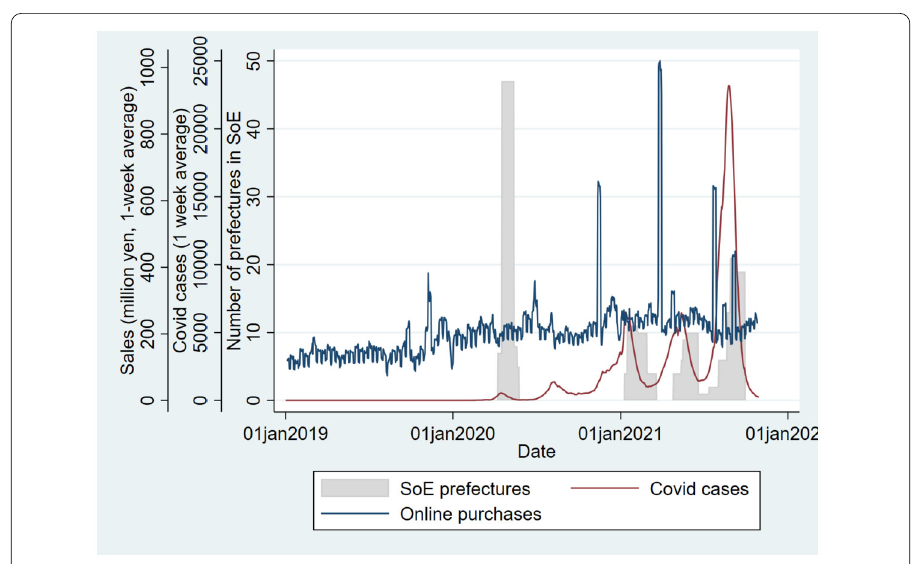
Figure 2 Changes in COVID-19 Cases and Online Purchases and Buyers over Time from January 1, 2019, to October 30, 2021. This figure shows the total number of daily positive COVID-19 cases in Japan averaged over one week (the red line), the number of prefectures in a state of emergency (SoE) due to COVID-19 (the shaded area), and the total number of daily purchases on the online shopping platform in Japan (the blue line). Data source: Ministry of Health, Labor and Welfare [33] and Cabinet Secretariat of Japan